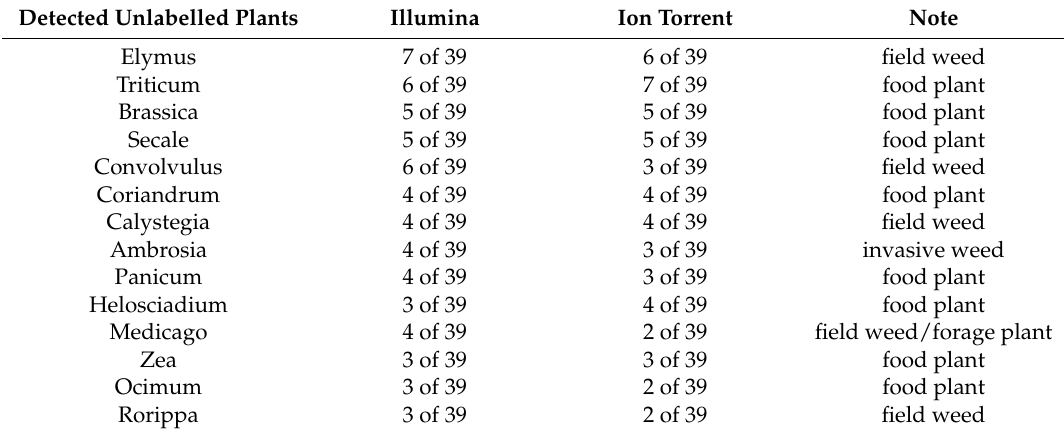
Table 2. Unlabelled plants that are the most frequently